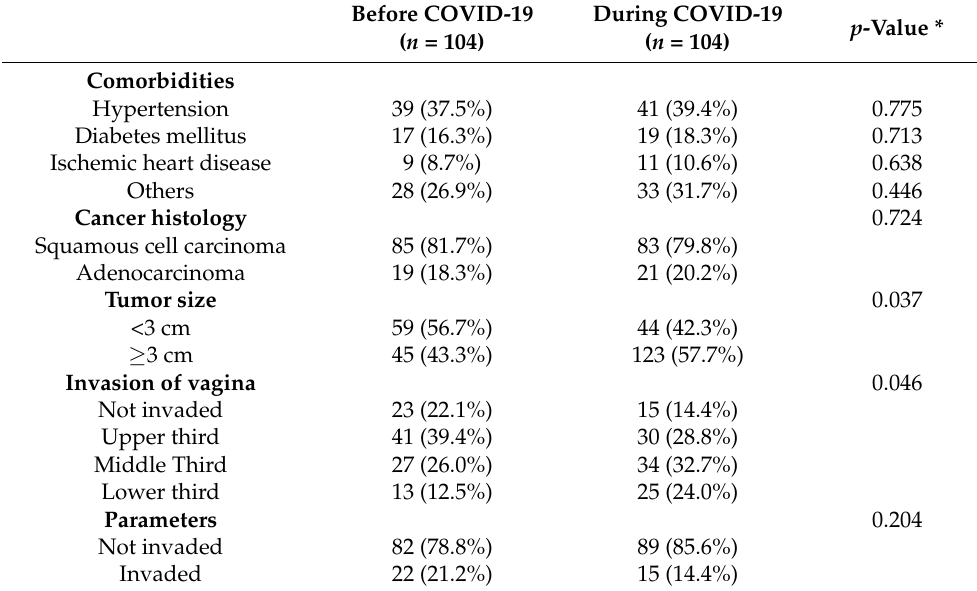
Table 2. Cervical cancer characteristics of women undergoing radiation therapy before and during the COVID-19